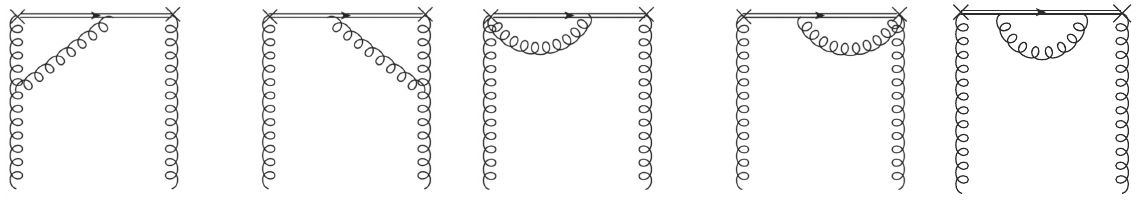
Figure9:One-loopcorrectionstoagluonquasidistribution,whichinvolvetheWilsonline(doubleline).Thesymbol“ × ”denotesthenonlocal vertex from the operator. Source: [136], reprinted with permission by the Authors (article published under an open access